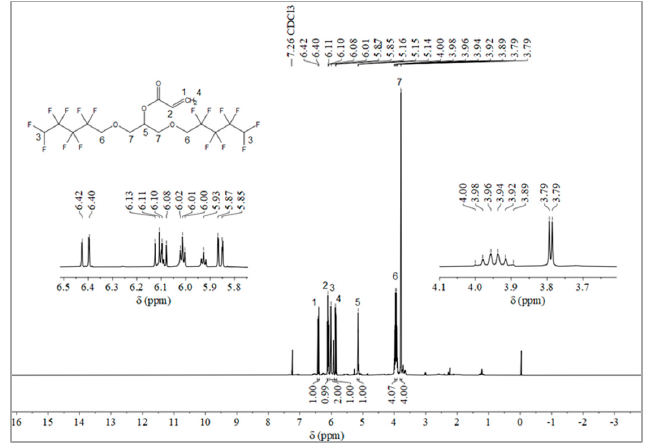
1 H NMR spectra of OFAE. Figure 6.